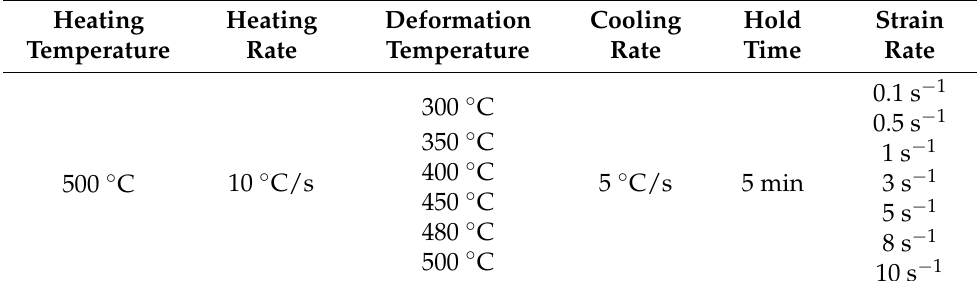
Figure 2. Thermal simulation process curve. Table 1. Hot compression test scheme.